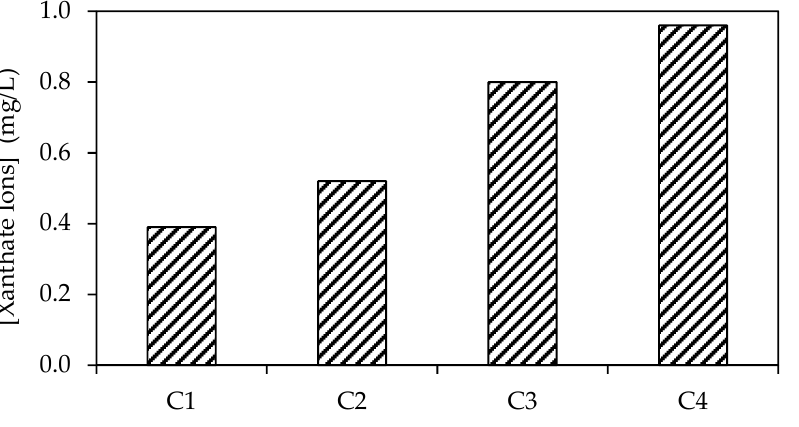
Figure 9 . Xanthate ion concentration in Zn Rougher Tail water during water recirculation without AC treatment.